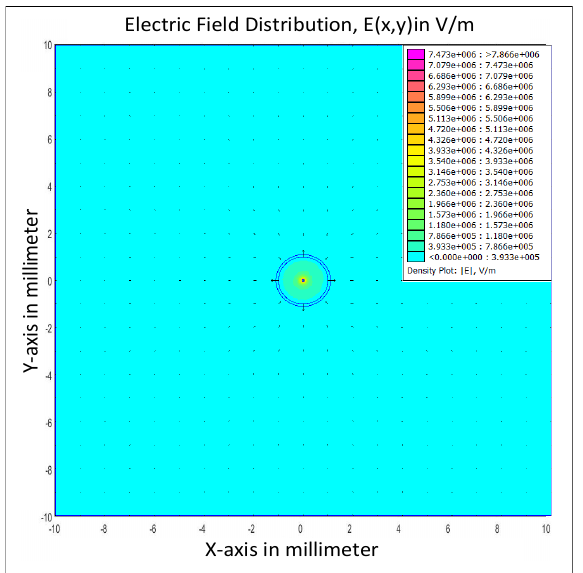
Figure 6. The electric potential distribution of the proposed device.